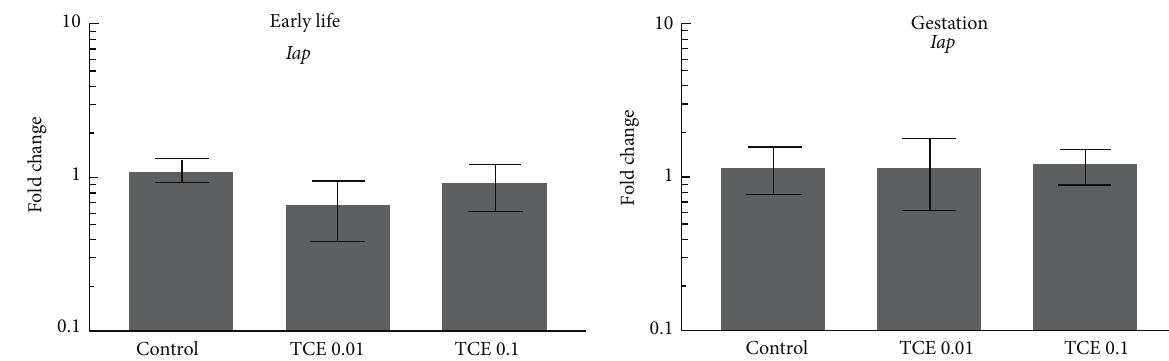
Figure 6: TCE did not inhibit Iap in thymocytes from either window of developmental TCE exposure. Gene expression was examined in thymocytes incubated for 18 hours following isolation from untreated control mice or from mice exposed to TCE during gestation only, or during early life only. The data represents the mean ± SD. ∗ Significantly different ( 𝛼 < 0.05 ) compared to control values.